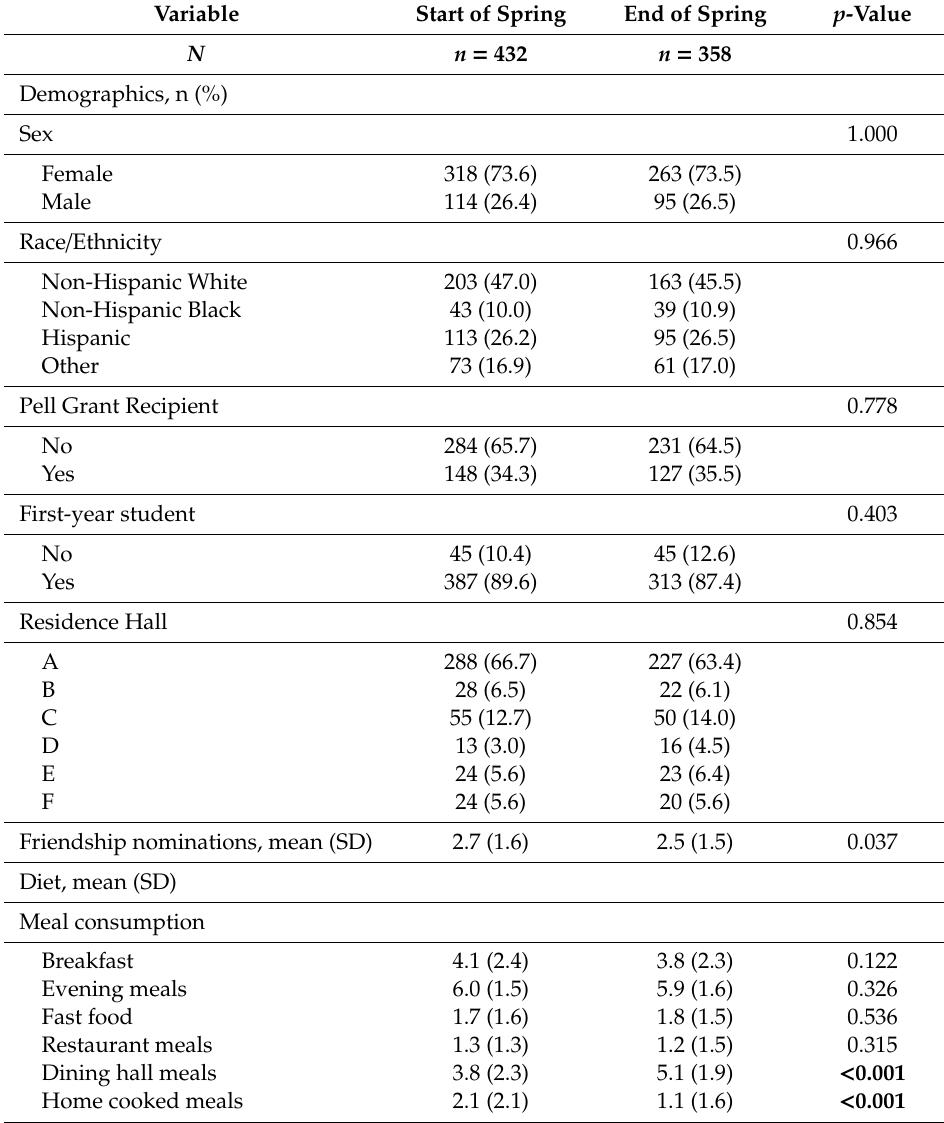
Table 1. Key demographics of students included in cross-sectional analyses examining the association of friend similarity with weight-related behavioral factors ( n =